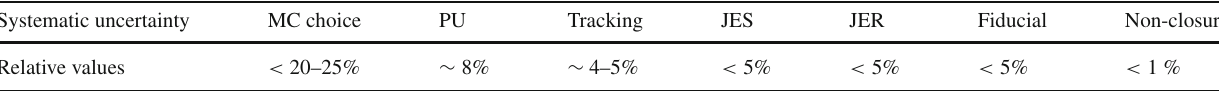
Table5 Summarytableofsystematicuncertaintysources:MCgeneratorchoicefortheunfolding, pile-up(PU)mismodelling,trackinginefficiency, JES and JER, non-fiducial events, and non-closure test Systematic uncertainty